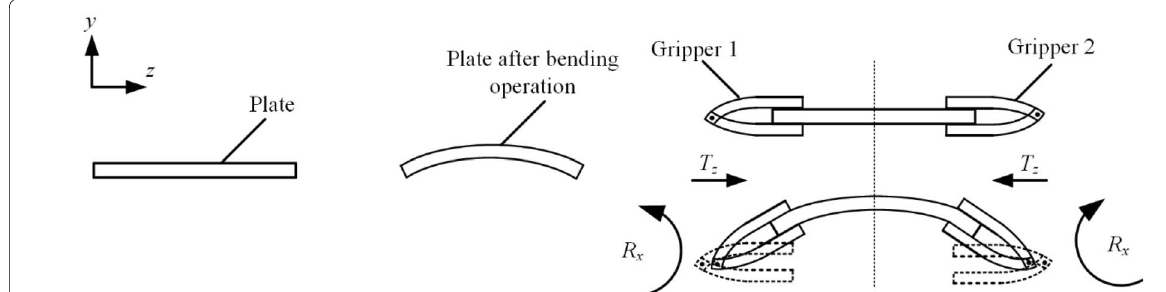
Figure 16 Diagram of the plate bending operation